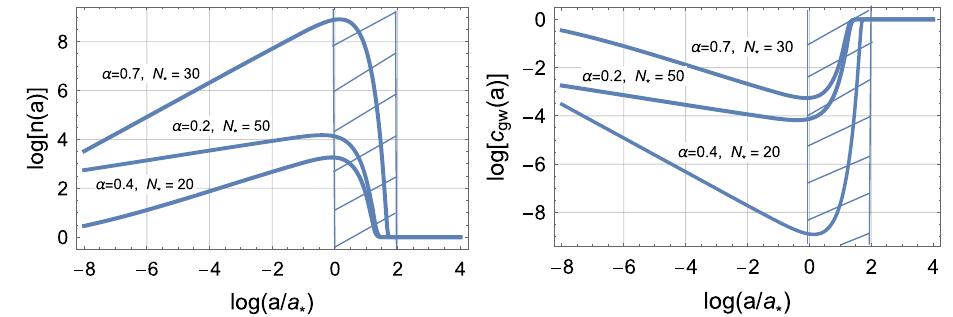
Fig. 1 In the left plot the common logarithm of the refractive index as a function of the scale factor is illustrated for two profiles characterized by different values of α and of N ∗ . In the right plot we report instead the